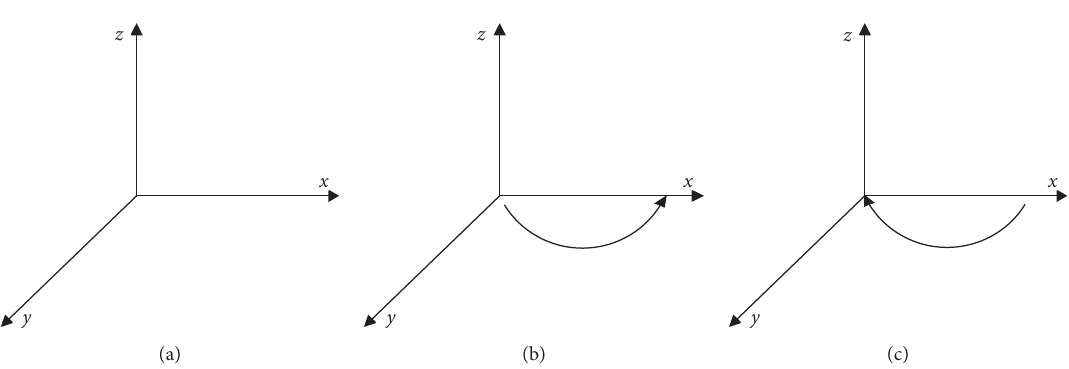
Figure 2: Dynamic phase diagram of local government strategy selection stability evolution and